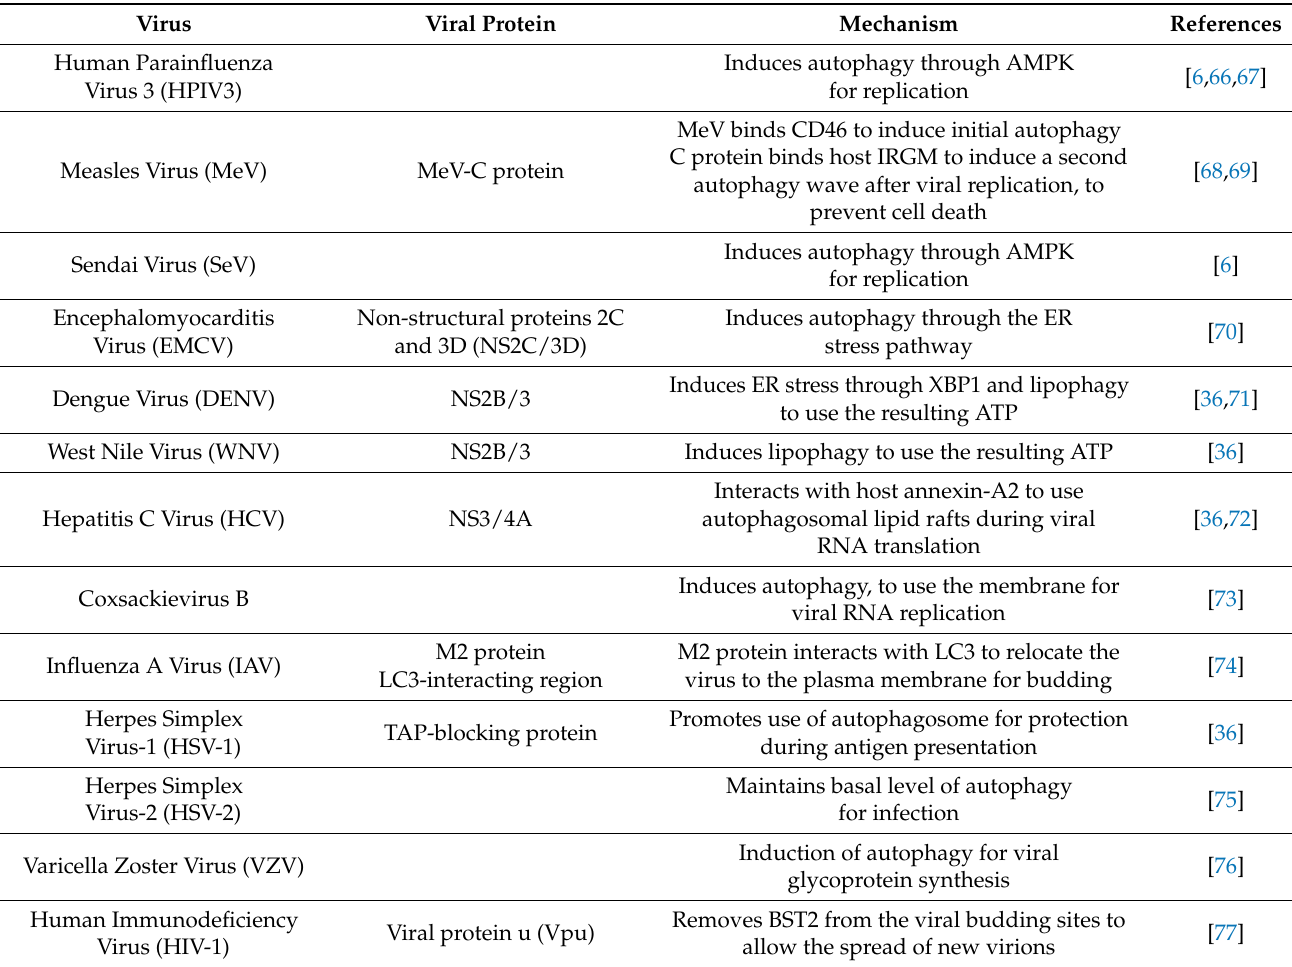
Table 2. Virus-induced autophagy as a pro-viral